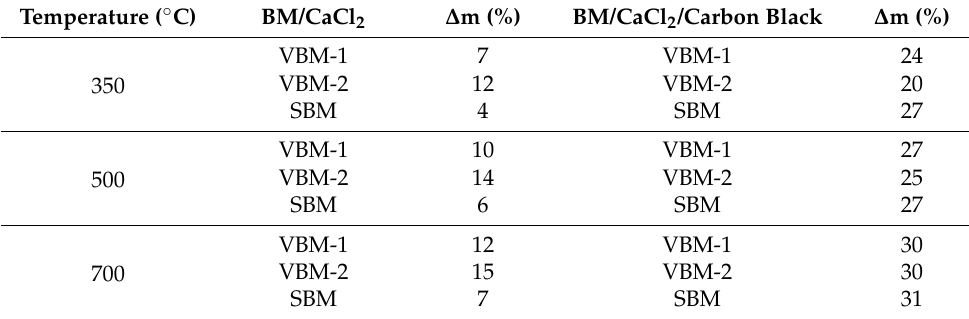
Table 2. Mass loss of the mixtures calcined at isothermal conditions.